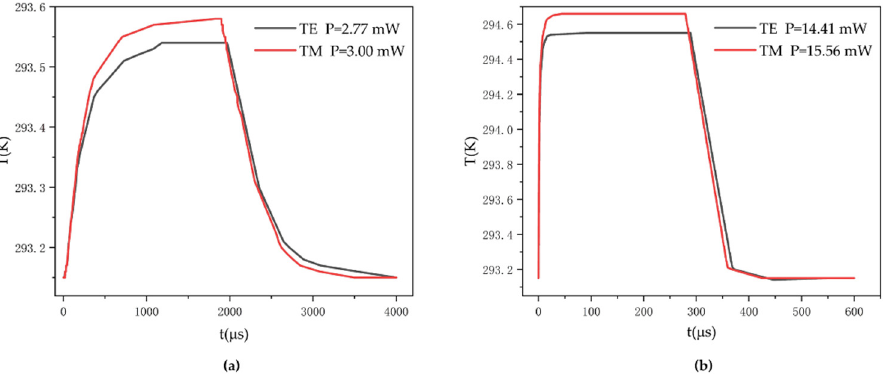
Figure 11. Simulation of the relationship between temperature and the time of the devices ( a ) using low thermal conductivity polymer (0.0125 W/mK) and ( b ) using high thermal conductivity polymer (16 W/mK).